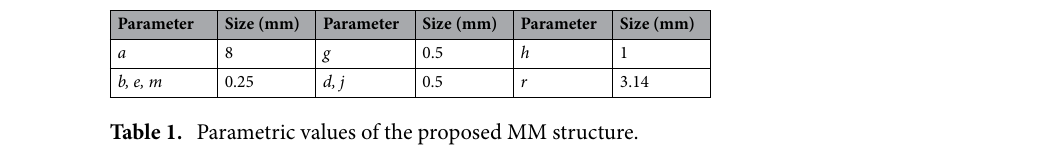
Table 1. Parametric values of the proposed MM